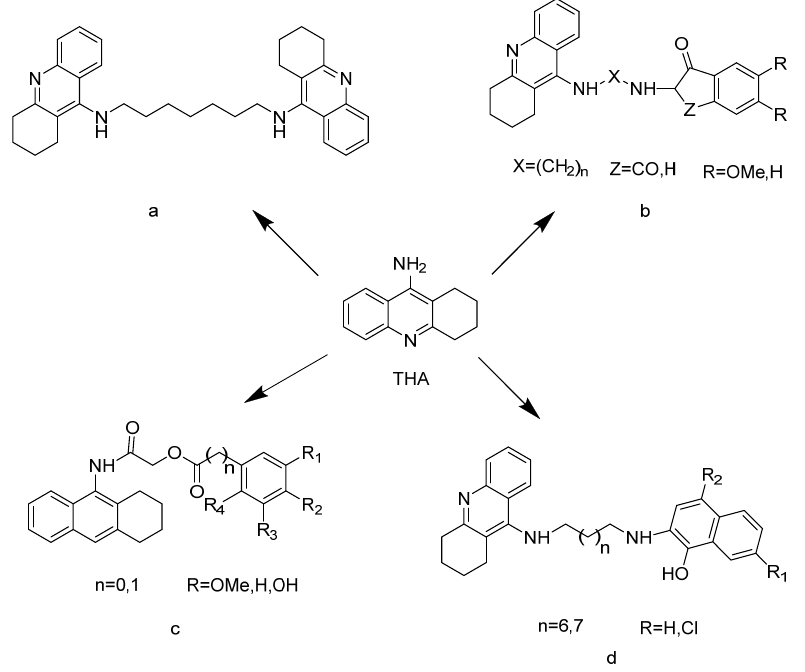
Figure 1. Structure of THA derivatives.